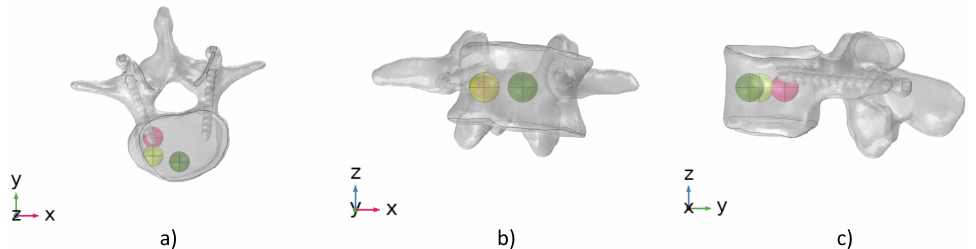
Figure 5. The different positions analyzed for the metastases are shown in transverse ( a ), anterior ( b ), and ( c ) sagittal planes: lateral right P1 (magenta circle); anterior right P2 (yellow circle); and anterior P3 (green circle).